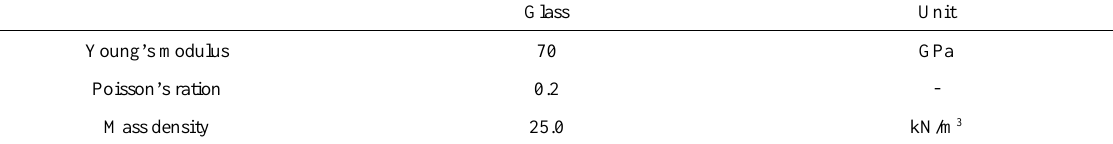
Table 1: Material properties glass.